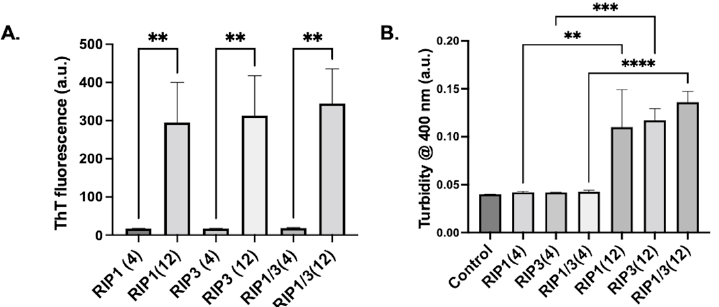
Figure 1. ( A ) Thioflavin-T characterization of aggregation of RHIM fragments of RIP1, RIP3, and RIP1/RIP3 complex after 1 day. RHIM fragments composed of 4 amino acid residues (RIP1(4), RIP3(4), RIP1(4)/RIP3(4)) and 12 amino acid residues (RIP1(12), RIP3(12), RIP1(12)/RIP3(12)) were used for the study. ( B ) Turbidity measurement of the corresponding RHIM fragment aggregates after 1 day. n = 3 ± SEM, ** p < 0.01, *** p < 0.001, **** p < 0.0001.